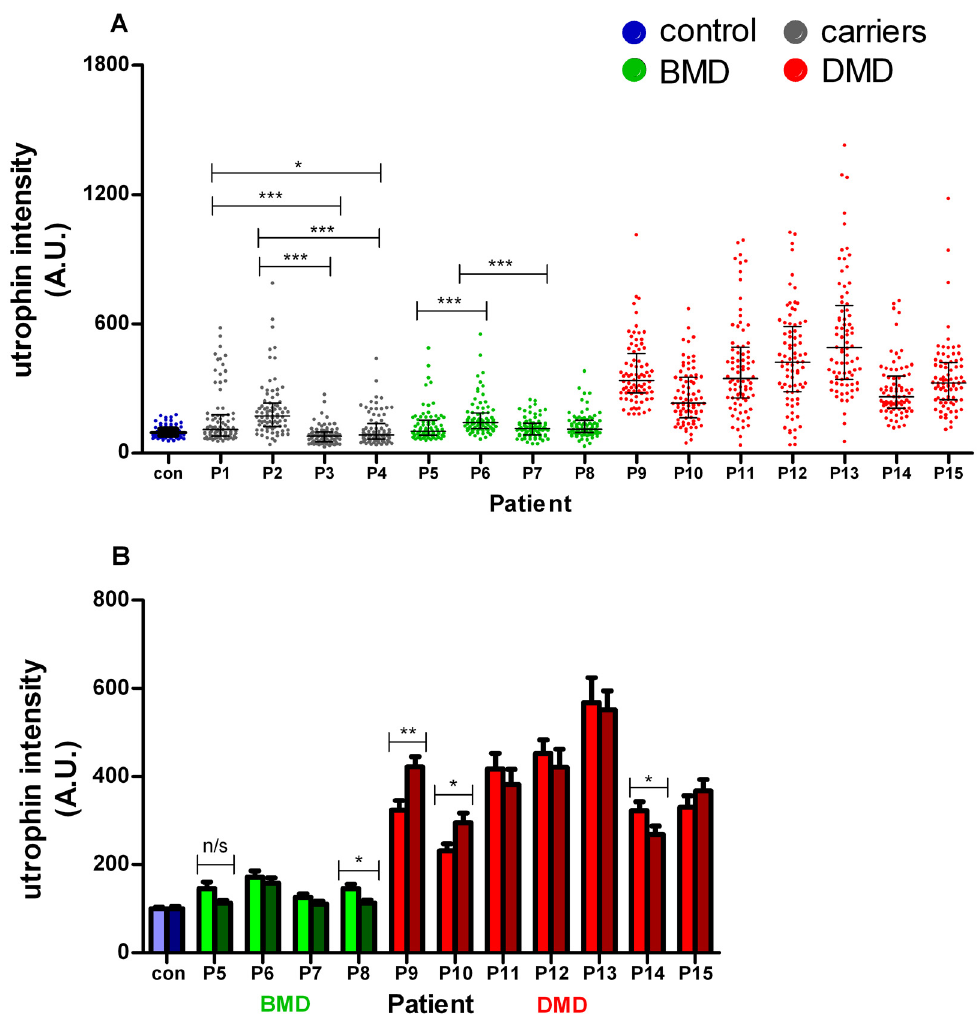
Fig 2. Quantification of utrophin in mature fibres by Metamorph software following normalisation to spectrin. (A) Utrophin intensity (arbitrary units; A. U.) quantified in control (blue dots), carrier (manifesting P1 and P2; non-manifesting P3 and P4; grey dots), BMD (P5-7; green dots), BMD/DMD intermediate (P8; green dots) and DMD (P9-15; red dots) quadriceps muscle. The dot plot depicts the median utrophin intensity ( ± IQR) in mature muscle fibres from replicate experiments performed on the same muscle but stained and quantified on separate occasions (80 fibres in total analysed). Each point represents a single sarcolemmal intensity reading on one individual myofibre, normalised to spectrin and expressed as a percentage of the average intensity in the 3 non- pathological controls. Intensity measurements distinguish BMD from DMD muscle biopsies. Data are from 2 replicate experiments combined and a Kruskal- Wallis one way analysis of variance followed by Dunn ’ s test was performed for all comparisons. (B) The variability between replicate experiments performed on control, BMD and DMD muscle biopsies. Wilcoxon matched pair analysis used for comparison between replicate experiments ( * p < 0.05; ** p < 0.01; *** p < 0.001; n/s, not